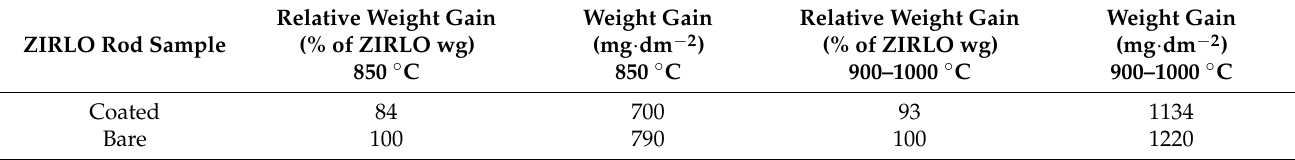
Table 1. Hot steam treated ZIRLO oxidation. Values of the weight gain (given in % and mg dm − 2 ) for ZIRLO protected by diamond coating and uncoated ZIRLO rods after the exposure to the hot steam treatment. Note: the recalculated (normalized) values of weight gains of the coated parts of the samples are given.